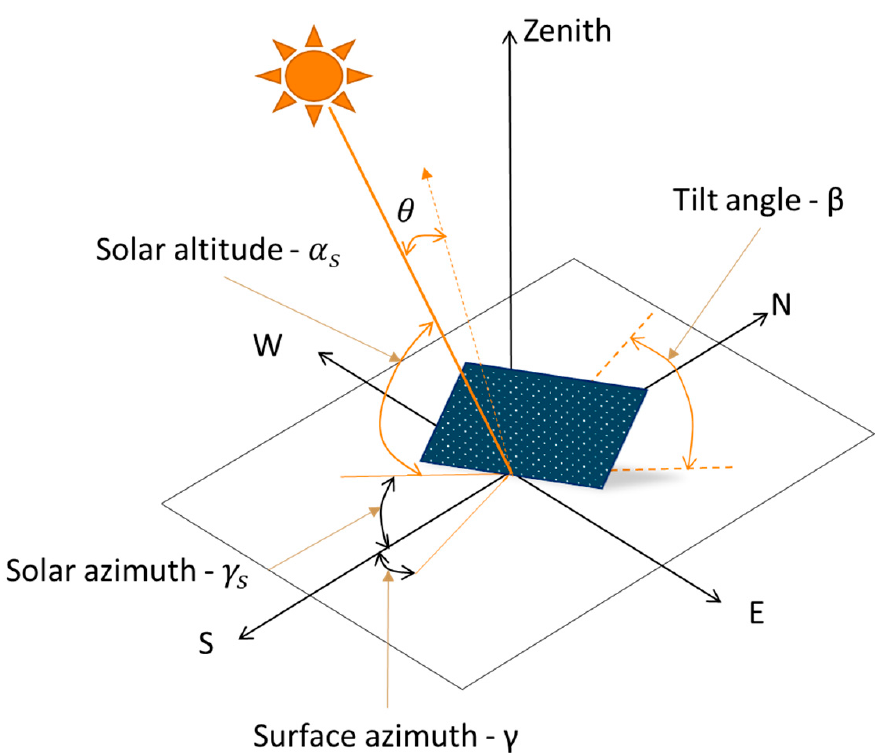
Figure 2. Solar and PV module characteristic angles. Reproduced with permission from the authors of “Submerged and Floating Photovoltaic Systems”, Copyright Elsevier Science Publishing Co Inc., 2018 [33].